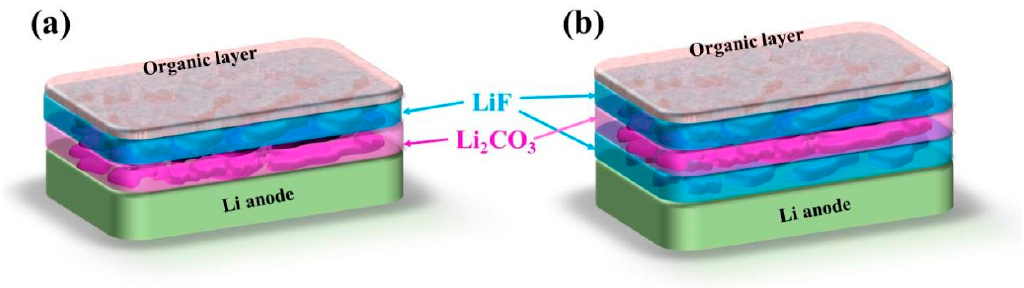
Figure 9. Schematic diagram of SEI film formation on the lithium metal anode with the FEC additive: SEI film model generated by the reaction between lithium metal with commercial electrolyte ( a ) and 5% FEC ( b ).